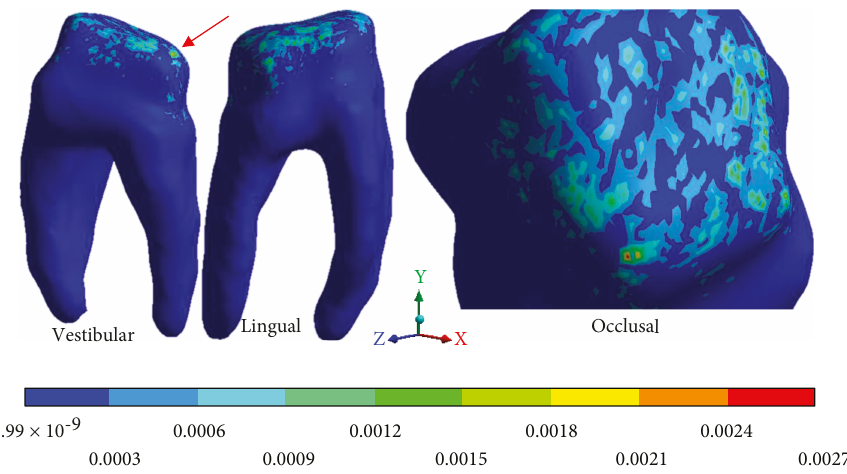
Figure 7: Control case: von Mises stresses in dentin.